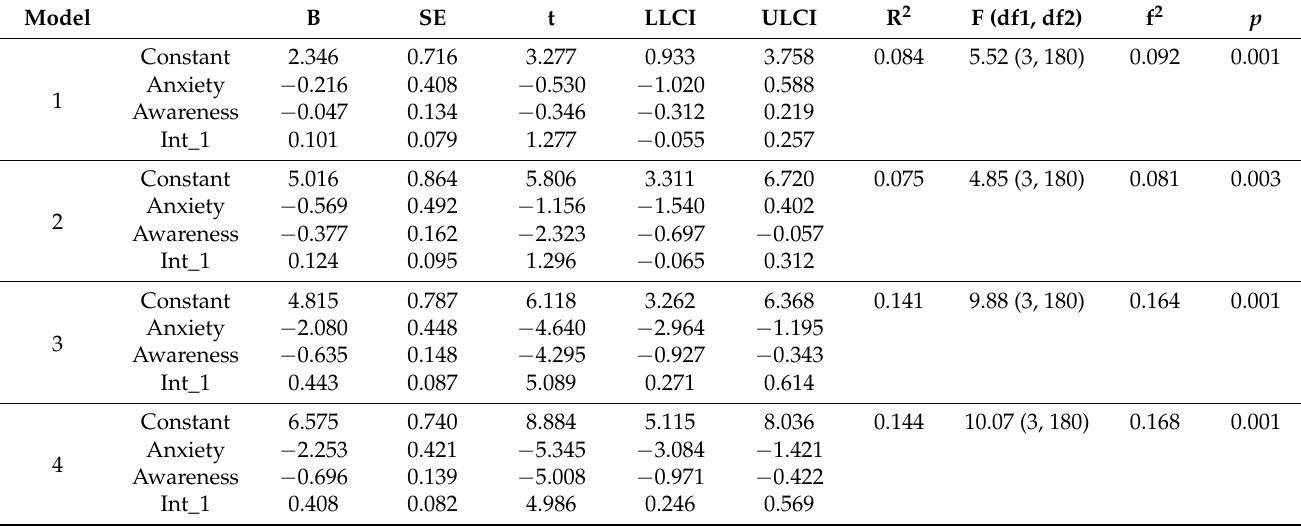
Table 4. Moderating effect of COVID-19 awareness in the link between anxiety and coping strategies.